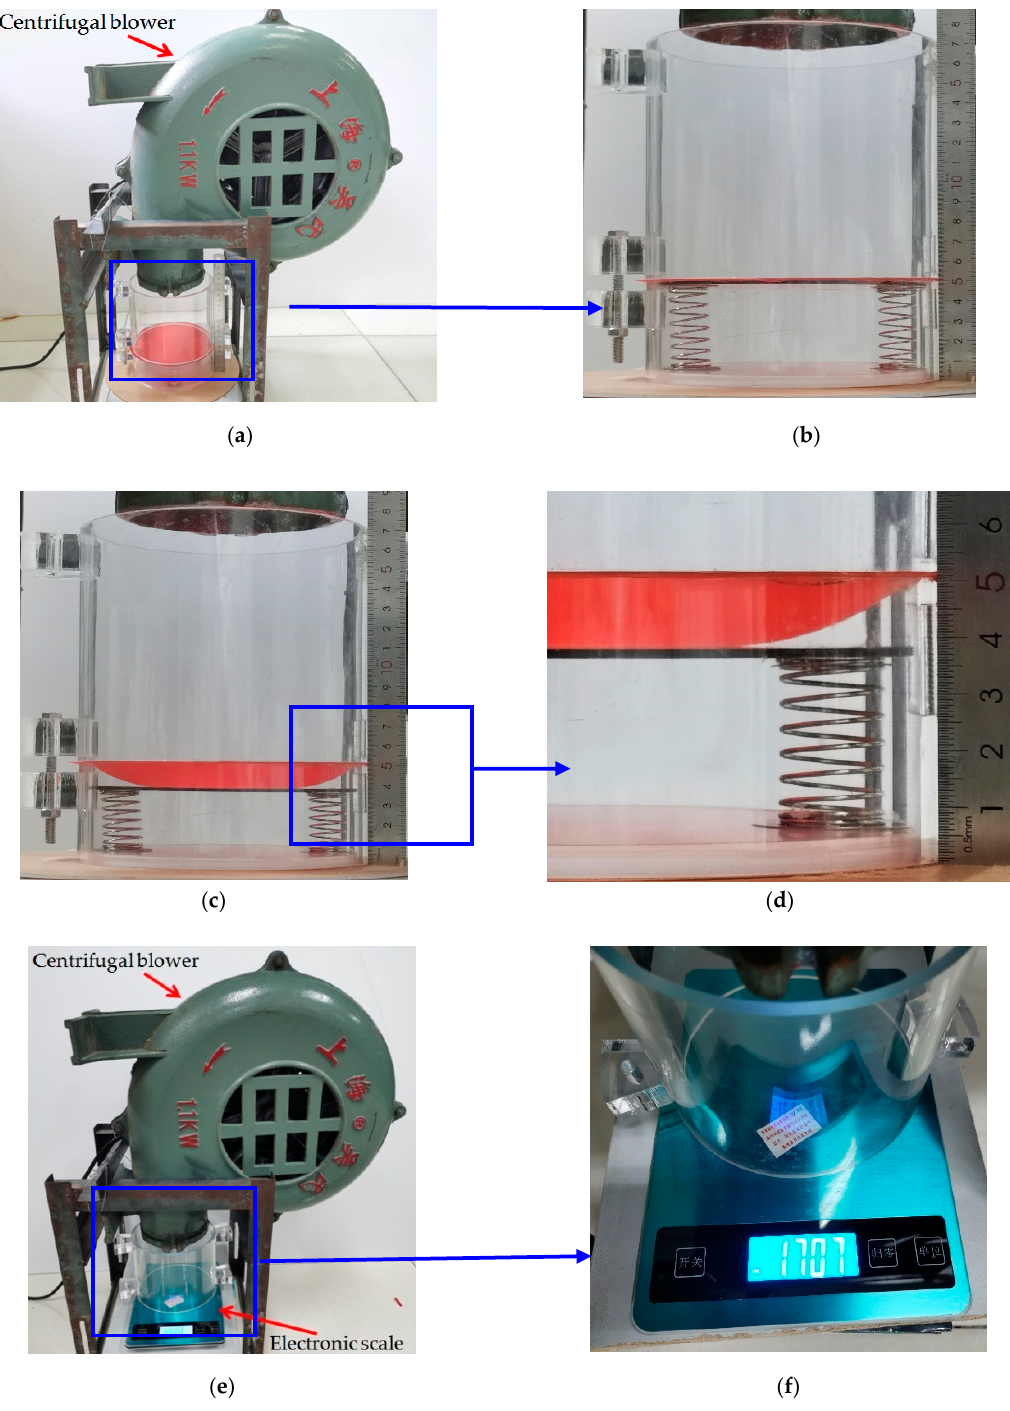
Figure 4. Experimental setup. ( a – d ) The case of loading the thin film, where ( a ) full view and ( b – d ) enlarged view; ( e – f ) The case of loads measurement, where ( e ) full view and ( f ) enlarged view.